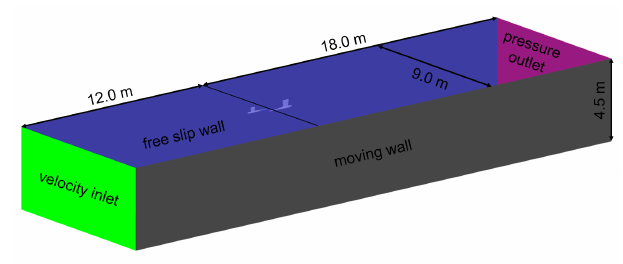
Fig. 2. Computational domain and boundary conditions for simu- lations.